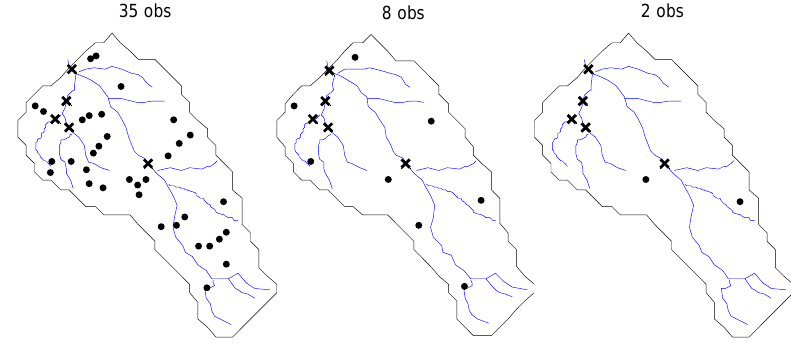
Figure 2. Spatial distributions of observations. Dots and crosses respectively denote groundwater hydraulic head and stream discharge observation locations, respectively.